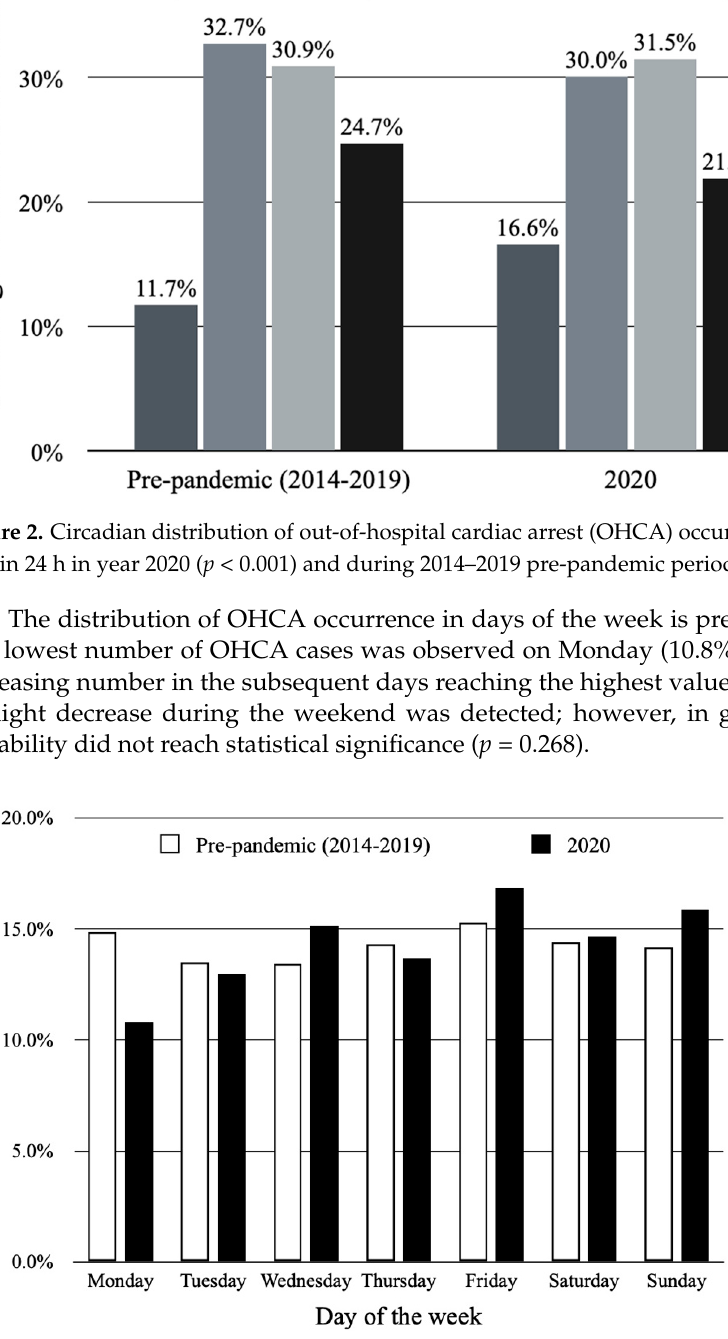
Figure 3. Distribution of out-of-hospital cardiac arrest (OHCA) occurrence in subsequent days of the week in year 2020 ( p = 0.268) and during 2014–2019 pre-pandemic period ( p = 0.499). Monthly ( p = 0.017) and seasonal ( p = 0.038) variability was observed during the year 2020. Figure 4 shows the monthly distribution of OHCA cases. The lowest OHCA occurrence was observed in September (6.3%; mean 0.87 ± 0.94) and was significantly lower in comparison to the highest observed in November (13.2%; mean 1.83 ± 1.15, p < 0.001) and October (11.1%; mean 1.48 ± 1.12, p = 0.029). The season with the highest proportion of OHCA cases (30.5%; mean 1.40 ± 1.13) was autumn, significantly